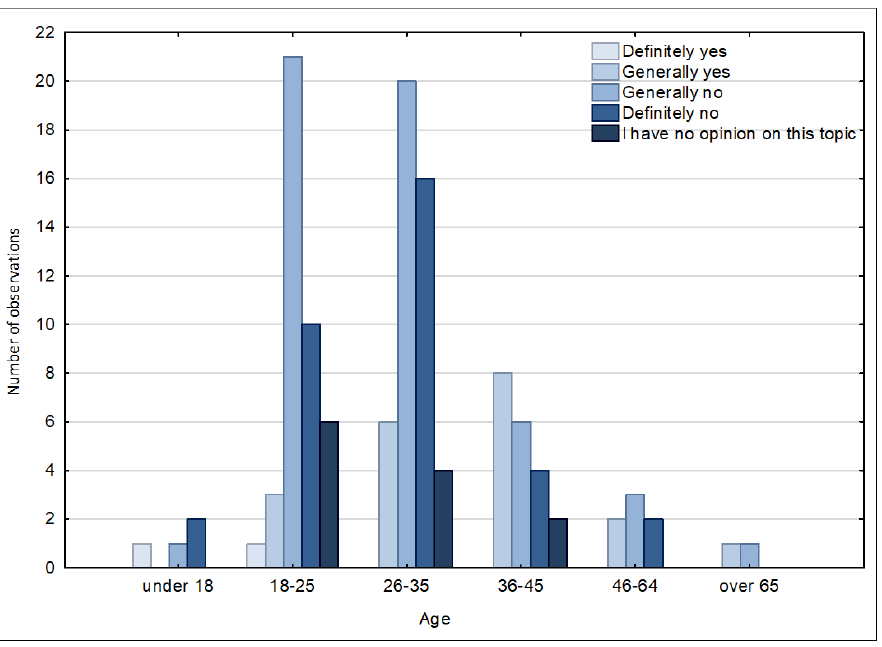
Figure 16. Assessment of the level of awareness of the smart city measures being taken by the city of Suwałki by age category. Source: own study based on questionnaire surveys.